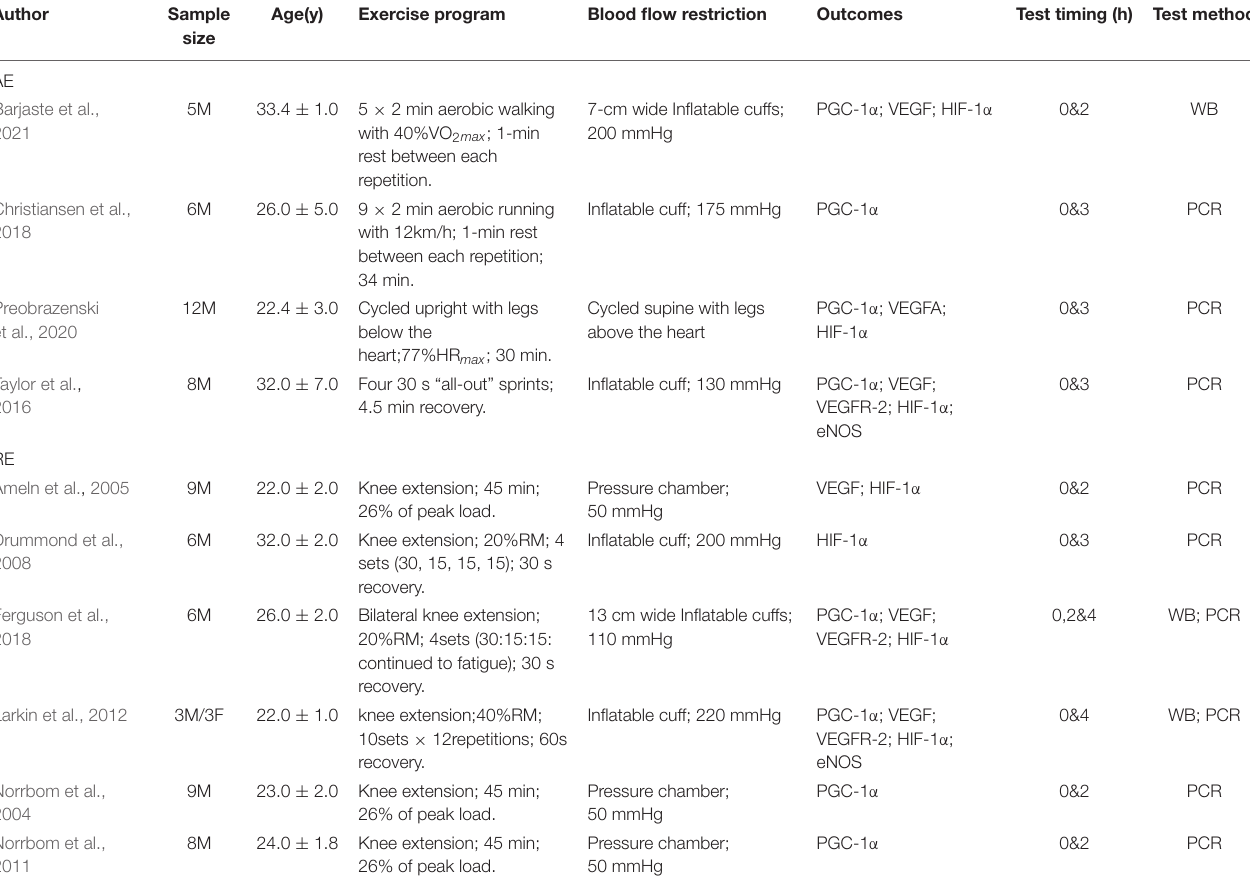
TABLE 1 | Overview of the included